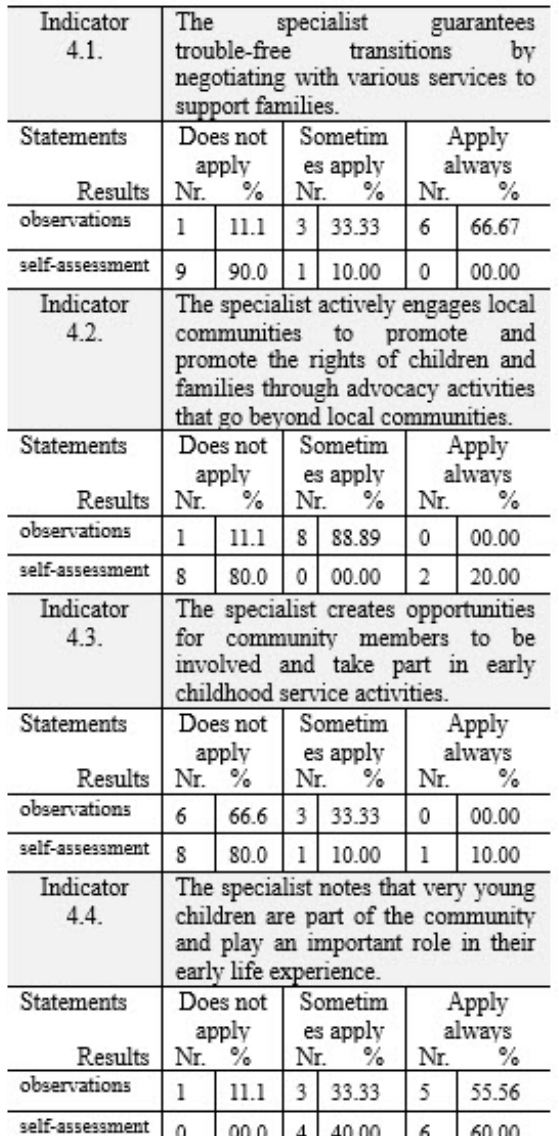
Table 9. Principle 4: Partnerships based on co-operative and community-based coop - eration best support families and